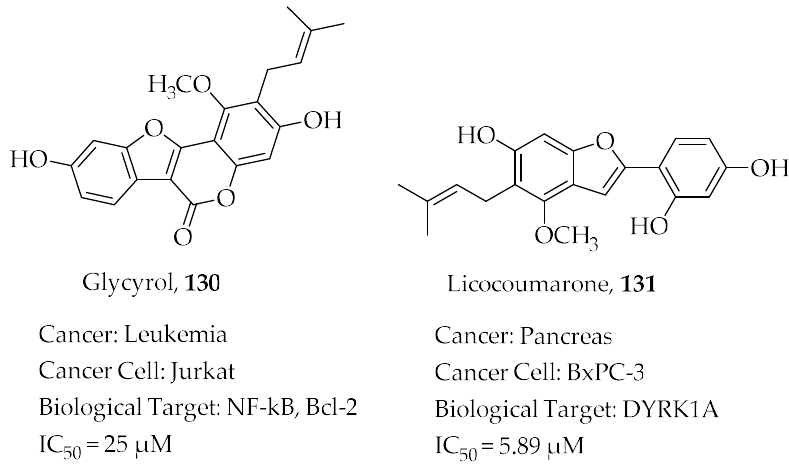
Figure 25. Structures of Glycyrol and Licocoumarone with a summary of their biological activity towards selected cancer targets.